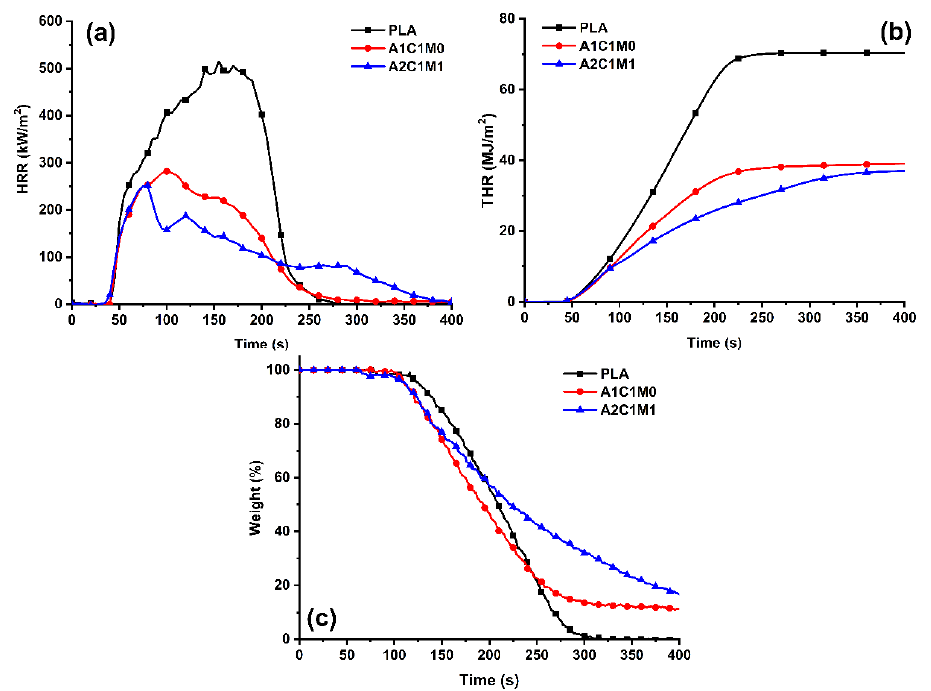
Figure 2. HRR ( a ), THR ( b ) and weight loss ( c ) curves of PLA and PLA composites. Table 2. CONE test results of PLA and PLA composites.